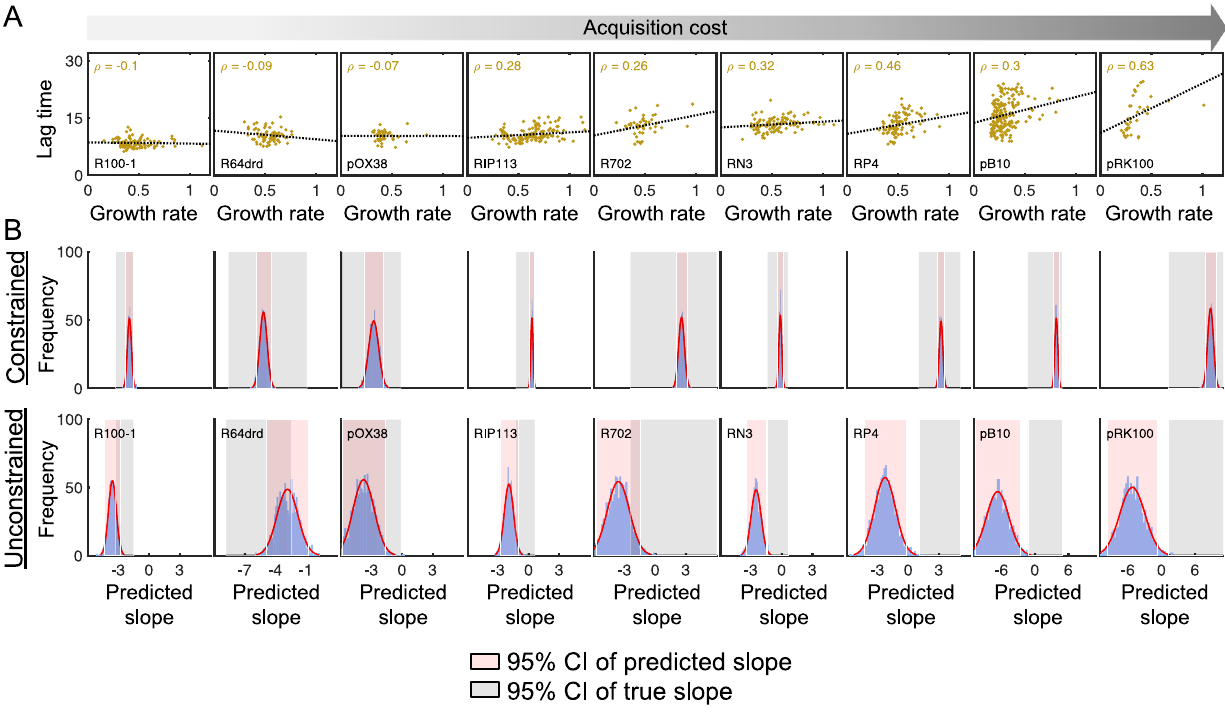
Fig.3|Lagtimeandgrowthratetradeoffasafunctionofacquisitioncost.A Lag time in hours (y-axis) as a function of growth rate (x-axis) for nine plasmids under tetracycline selection (i.e., Fig. 2A) shown in order of increasing acquisition cost (gray arrow, left to right). Individual markers represent de novo (yellow) colonies. Black lines represent the linear regression line of best fi t, and the Pearson corre- lationcoef fi cient( ρ )isreportedforeachpopulation.Colonynumbersarethesame asthosereportedinFig.2A,andarelistedinSupplementaryTable1c. B 300clones with bootstrapped lag times were generated in 1000 independent rounds; in each round, associated growth rates that were either unconstrained (bottom) or